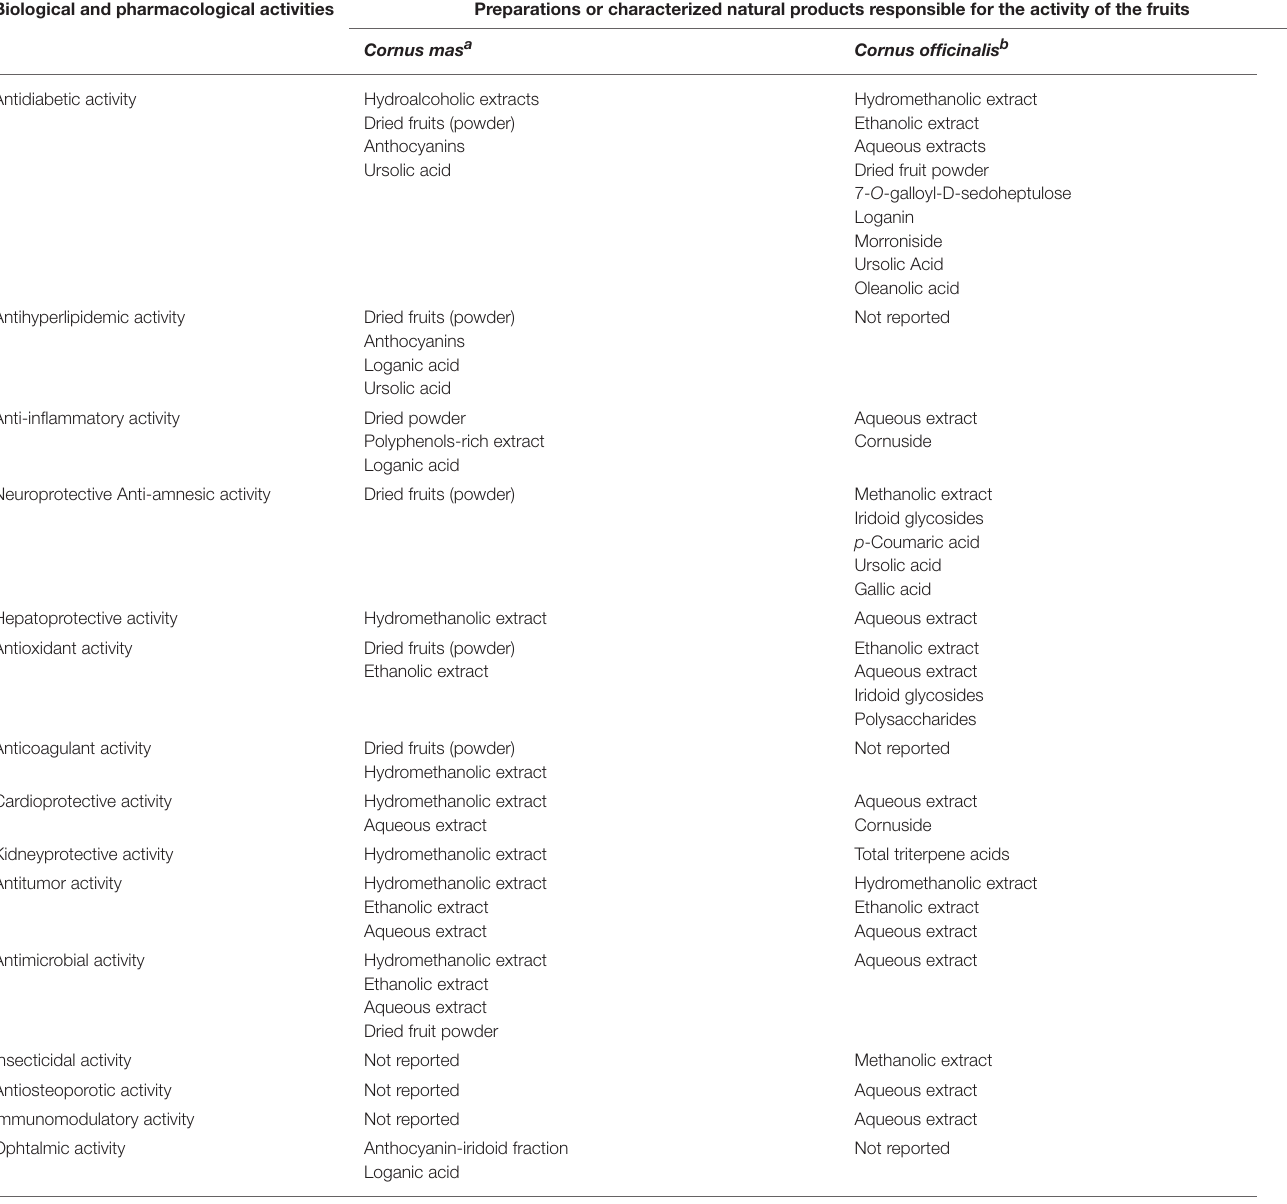
TABLE 2 | Similarities and differences of the biological or pharmacological activities of fruits from C. mas and C. officinalis . Biological and pharmacological